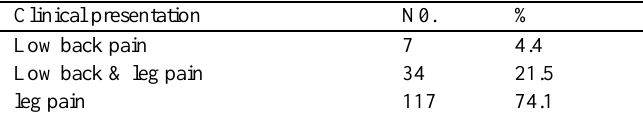
Table.2: Clinical presentation with positive MRI findings.